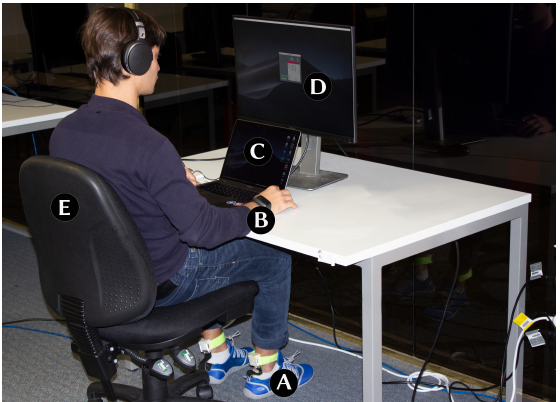
Figure 4. Experimental setup: ( A ) StressFoot prototype, ( B ) Empatica E4 wristband, ( C ) Macbook Pro, ( D ) Dell LED monitor and ( E ) adjustable